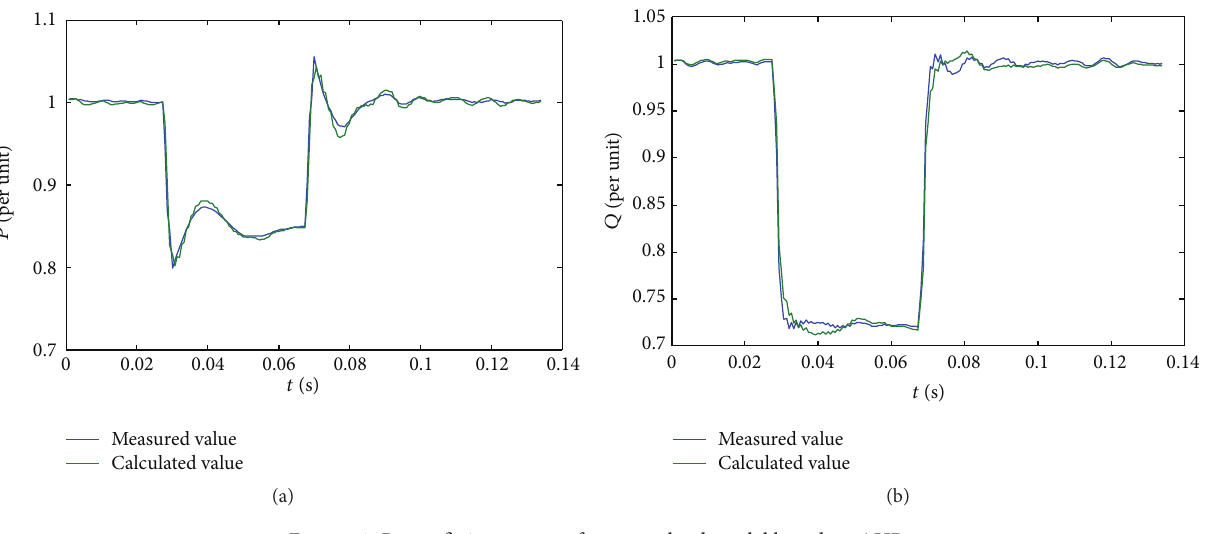
Figure 9: Power fitting curves of accurate load model based on